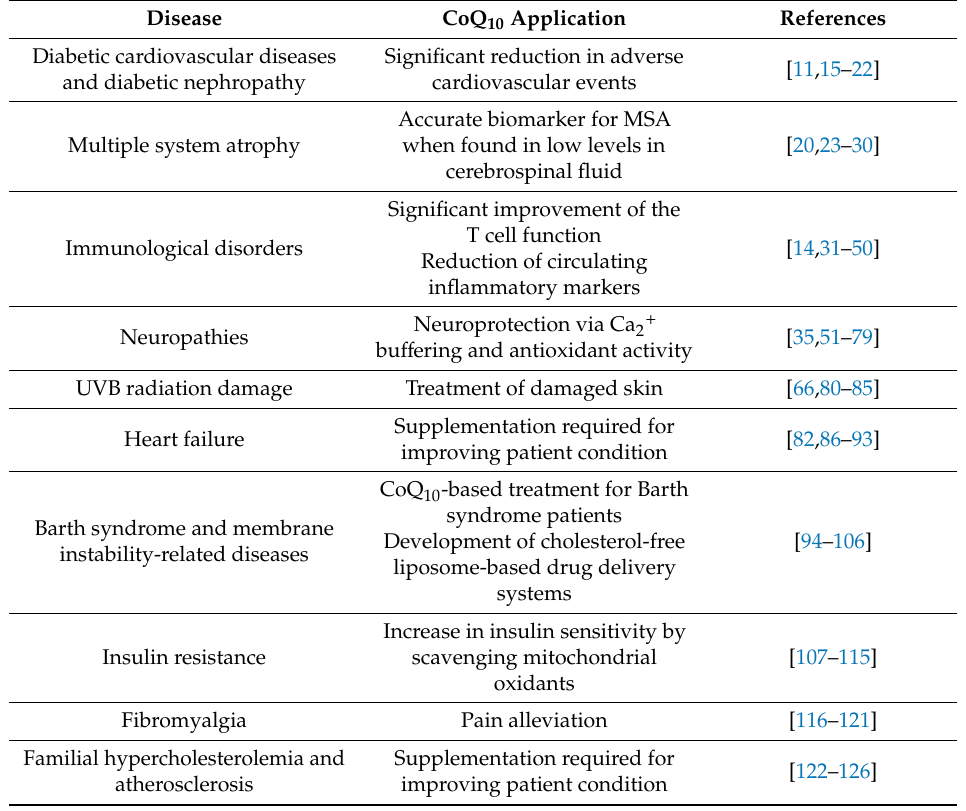
Table 1. Novel medical applications of CoQ 10